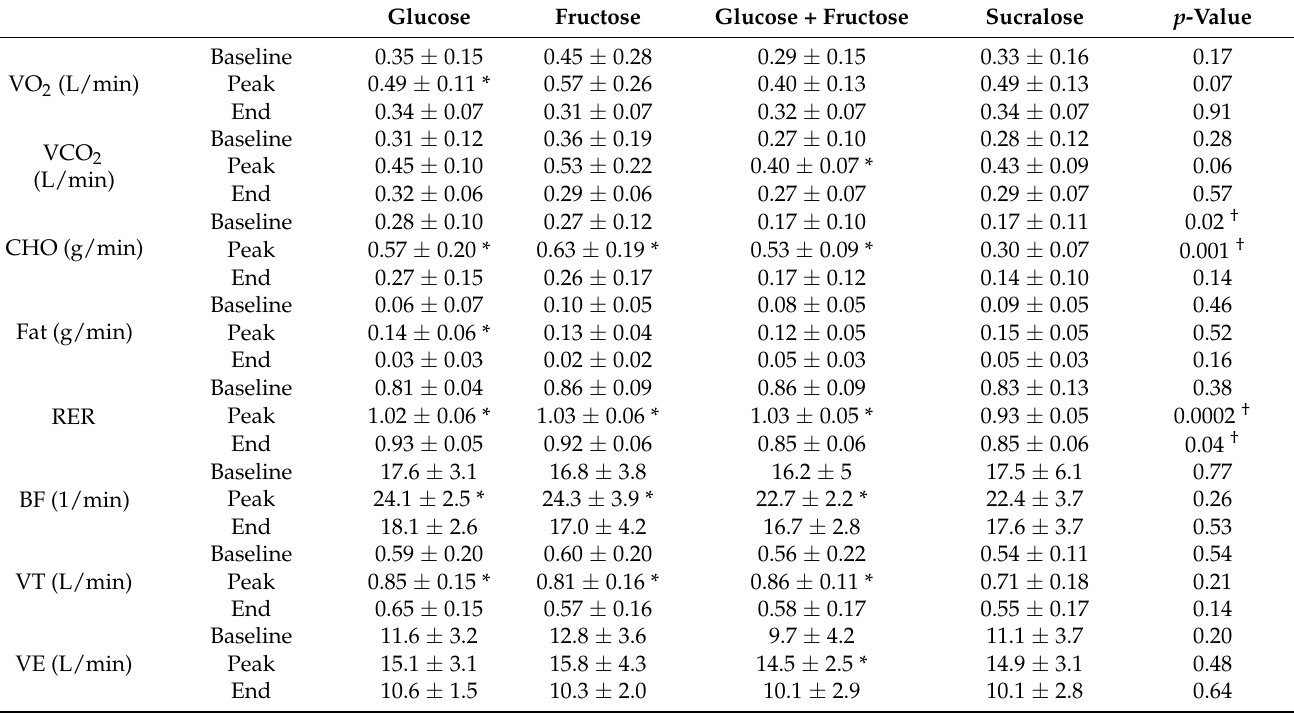
Table 1. Respiratory parameters during the 2-h